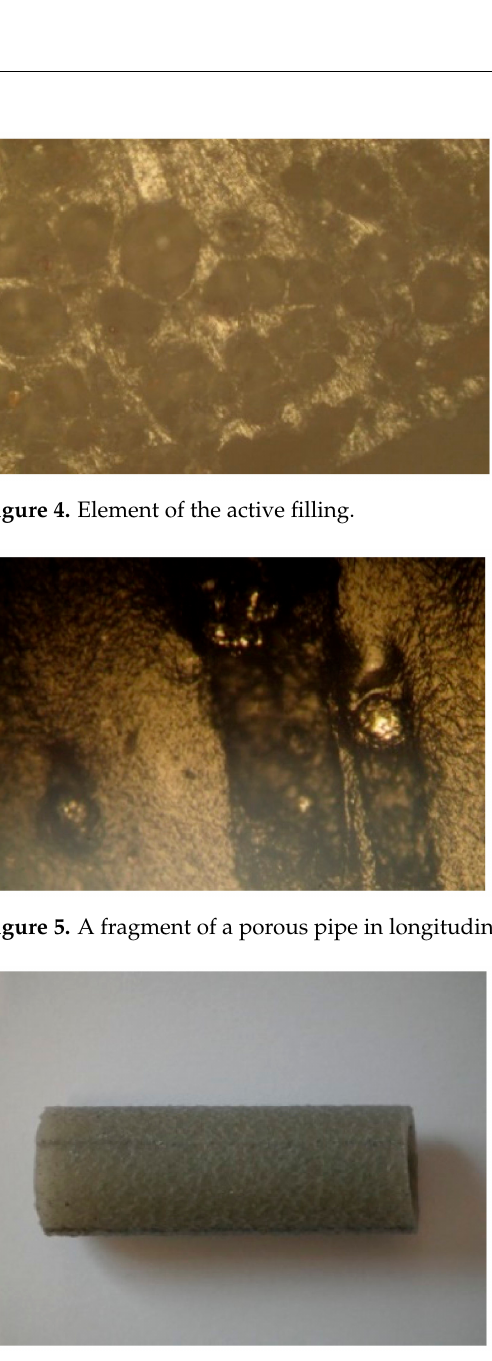
Figure 6. A fragment of the outer layer of a porous pipe with visible metal